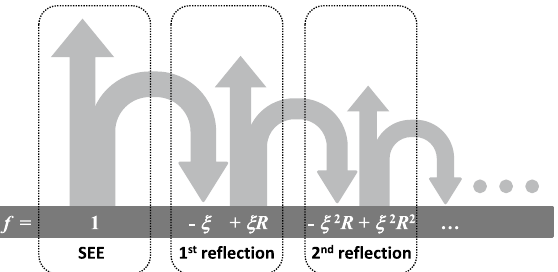
Figure 2. Schematic representation of the SEE process with multiple reflections.